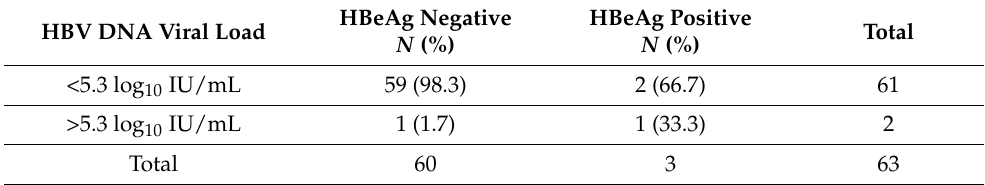
Table 2. HBV DNA viral load as a function of HBeAg in pregnant women with hepatitis B virus infection. HBV DNA Viral Load